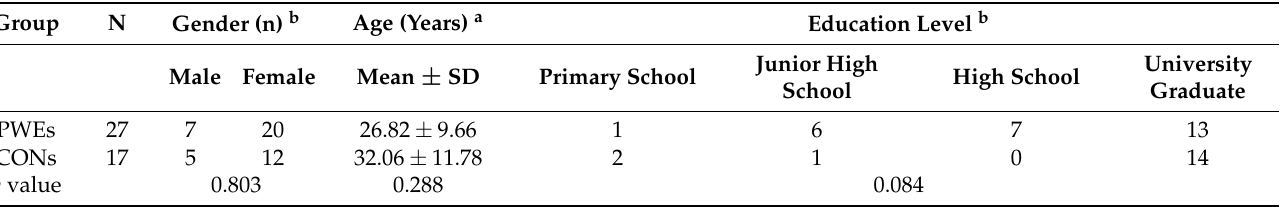
Table 2. Demographic characteristics of two subject groups. a means that a t -test was used. b means that the Mann–Whitney U nonparametric test was